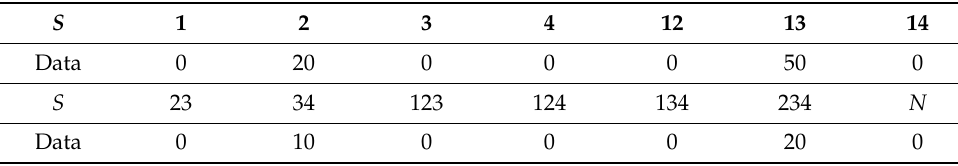
Table 2. Stolen data distribution among